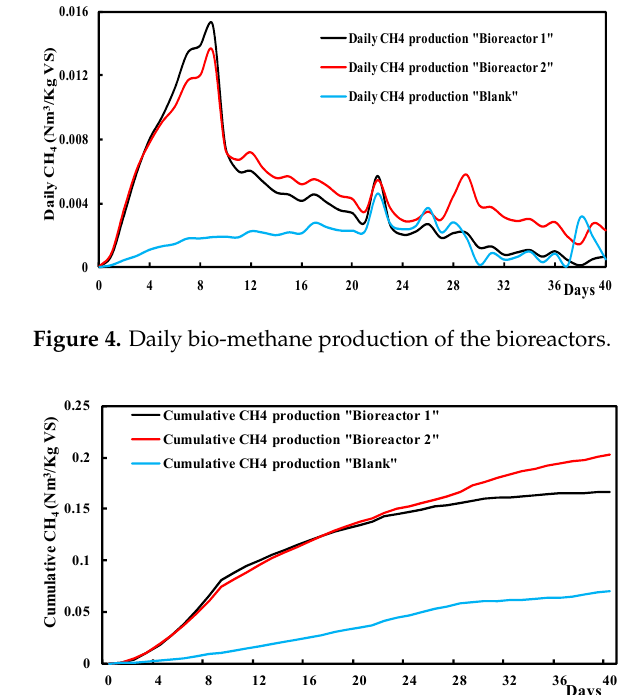
Figure 3. Cumulative biogas production of the bioreactors.